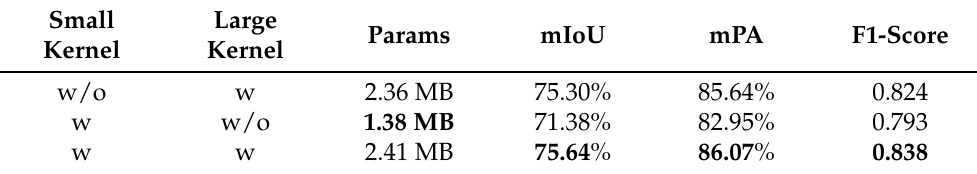
Table 3. Ablation study results for the mixture of small and large kernels.